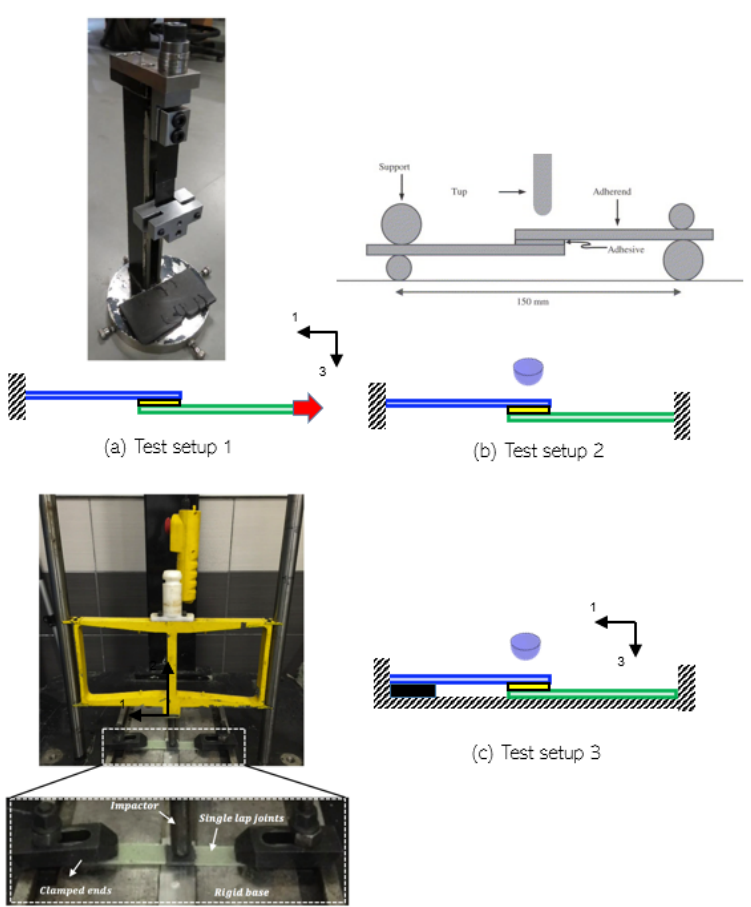
Figure 4. Different test setups used for testing adhesive joints under impact loads